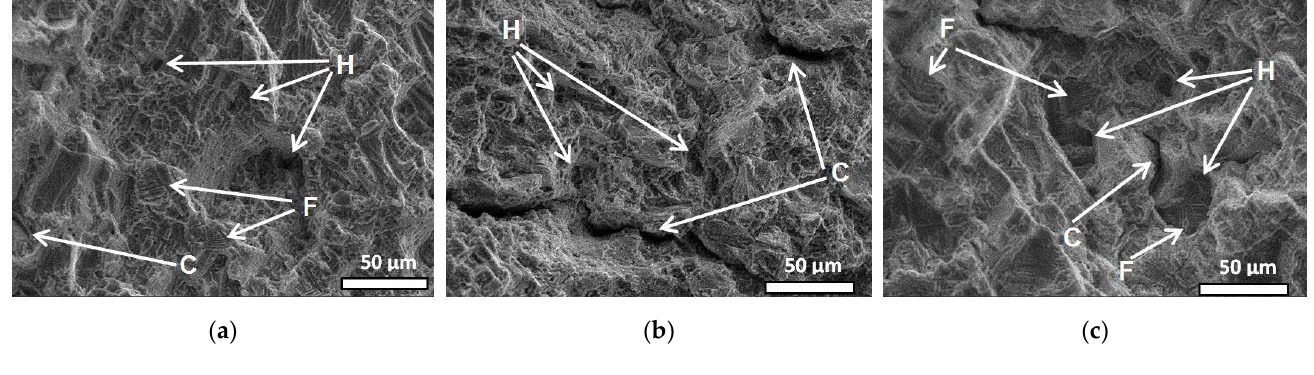
Figure 11. Fracture surface images. ( a )—initial product, ( b )—transition area, ( c )—repaired area. “H”—hole, “F”—facet, “C”— crack.